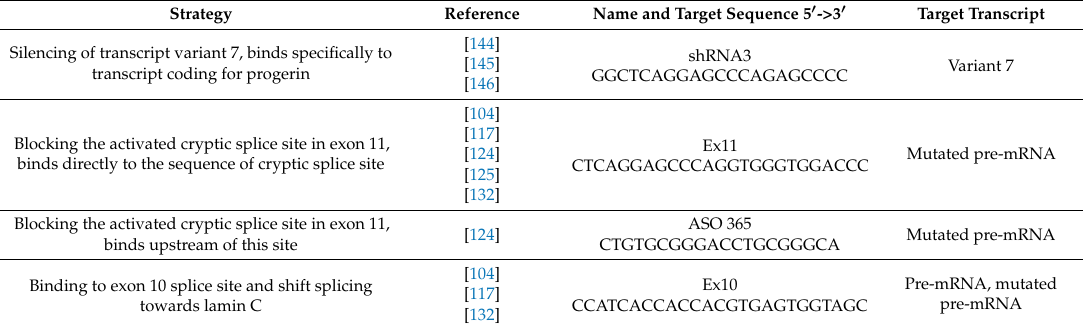
Table 2. Gene therapy tests and strategy used for HGPS treatment on tissue culture and mouse models.